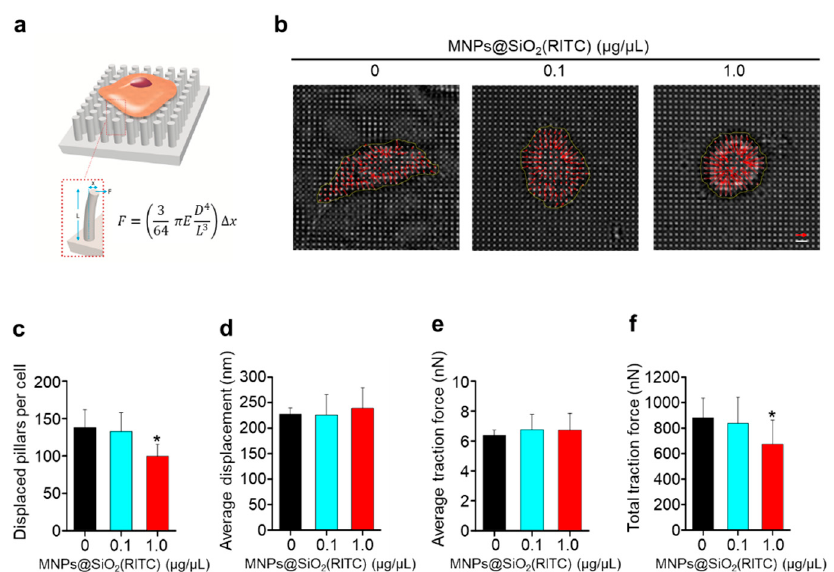
Figure 5. Change in pillar deflection, traction force, aspect ratio, and surface area of hBM-MSCs treated with MNPs@SiO 2 (RITC). ( a ) Schematic of traction force measurement using a micropillar. F = traction force; E = Young modulus of the pillar; D = diameter of pillar; L = length of pillar; ∆ x = pillar displacement. ( b ) Representative images showing the concentration of MNPs@SiO 2 (RITC) inside the cell, pillar deflections, and magnified pillar deflections at the edge of the cell (left to right). The red arrow represents 356 nm of deflection and the white bar represents 8 µm. The yellow line indicates the approximate cell boundary. The direction and length of the red arrow indicate the magnitude and direction of pillar deflection, respectively. ( c ) Displaced pillar number of pillar array ( d ) Average displacement of each pillar under the cell. ( e ) Average traction force of each pillar under the cell and ( f ) total traction force of pillars beneath the cell. Data represent mean ± SD ( n = 21). * p < 0.05 vs. non-treated control.